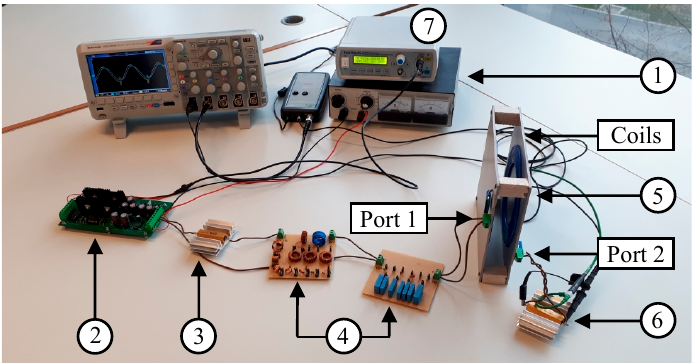
Figure 9. Experimental setup of the two-coil asymmetric wireless power transmission system (1 – DC power supply, 2 – high-frequency inverter, 3 – source impedance, 4 – impedance matching power supply, 2–high-frequency inverter, 3–source impedance, 4–impedance matching network, network, 5 – transmitting and receiving coils, 6 – load impedance). 5–transmitting and receiving coils, 6–load